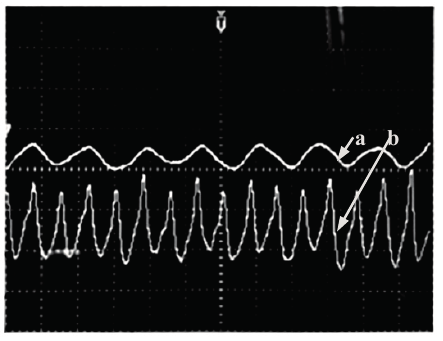
Figure 12. Respiratory rate (a) and heartbeat (b) signals.